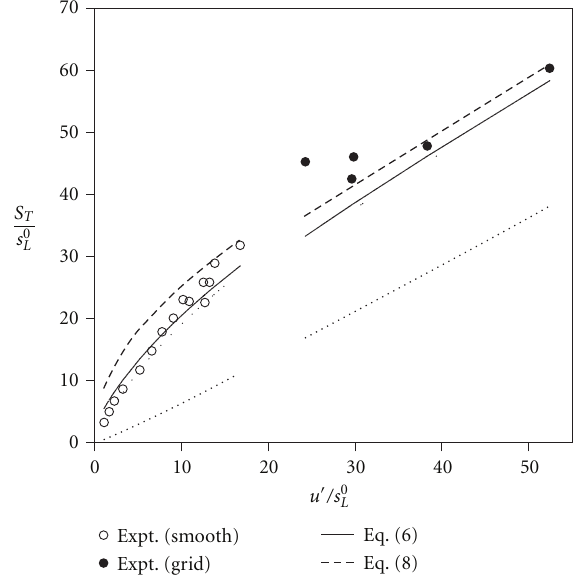
Figure 4: Comparisons of turbulent flame speed predictions to the experimental data of [34, 35]. The open circles denote the part of experiment where an open channel was used and closed circles denote the part where turbulence was generated by a grid. The short dashed line shows comparisons of (8) with K ∗ c =